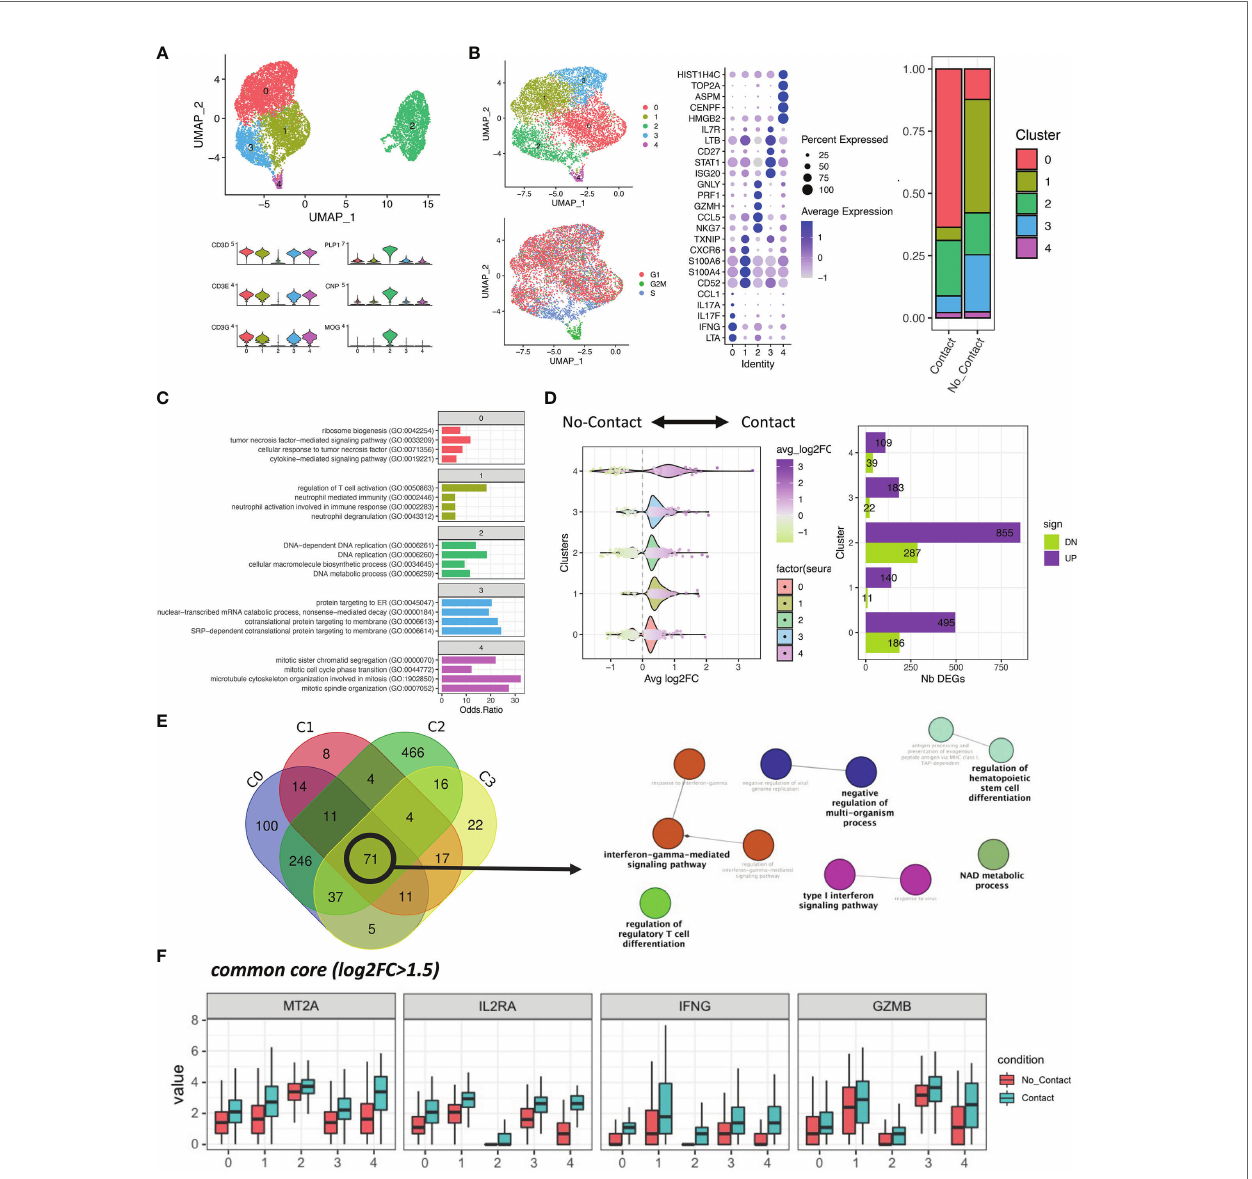
FIGURE 2 | Single-cell RNA sequencing reveals a transcriptional shift of Th17-polarized cells in contact with OLs. (A) Upper panel: UMAP of 9,236 cells. Doublets, cells with high mitochondrial content and residual myeloid cells were removed. Lower panel: Expression of T cells and mature oligodendrocyte (OL) canonical markers. (B) Left: UMAP of the re-clustered T-cell populations (6,954 cells). Right: Proportions of each unbiased cluster across the two conditions. Middle: Top fi ve markers across the fi ve obtained clusters, as found with MAST. (C) Top four most signi fi cant biological processes (GO) associated with the signi fi cant markers of each cluster. (D) Left: Distribution of the log2Fold changes between conditions across the fi ve T-cell clusters. Right: Total number of differentially expressed genes (DEGs) within each cluster, split by upregulated (purple) and downregulated (green) genes. (E) Venn diagram showing the overlap of DEGs between biologically relevant clusters (cell cycle-associated cluster removed) and network of biological processes (GO) signi fi cantly associated with the common core (71 genes). (F) Boxplot representation of the largest (adjusted p value < 0.0001 and log2FC > 1.5 in total Th17-polarized cells contact vs. no contact) upregulated genes upon direct cell contact with OLs across all T-cell clusters (all adjusted p value for contact versus no contact in every cluster <